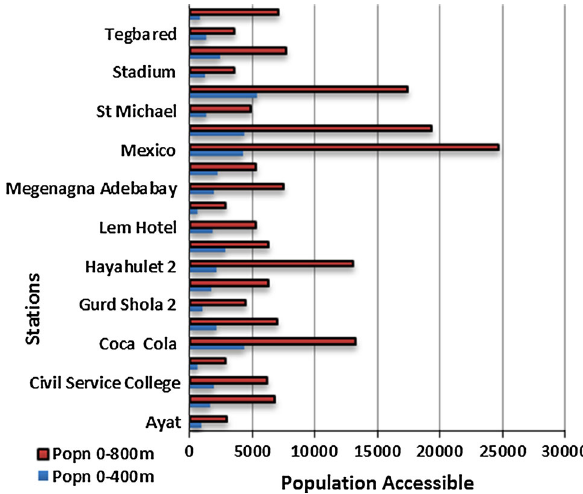
Fig. 4 Total number of population accessible within 0–400 and 0–800 m